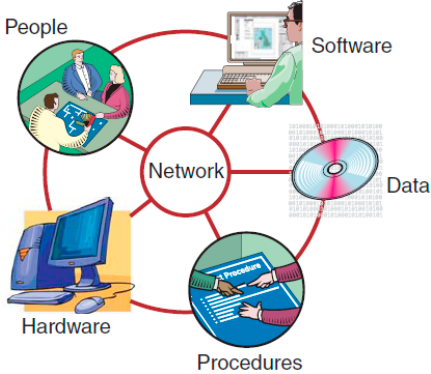
Figure 4. Geographic Information Systems (GIS) components.